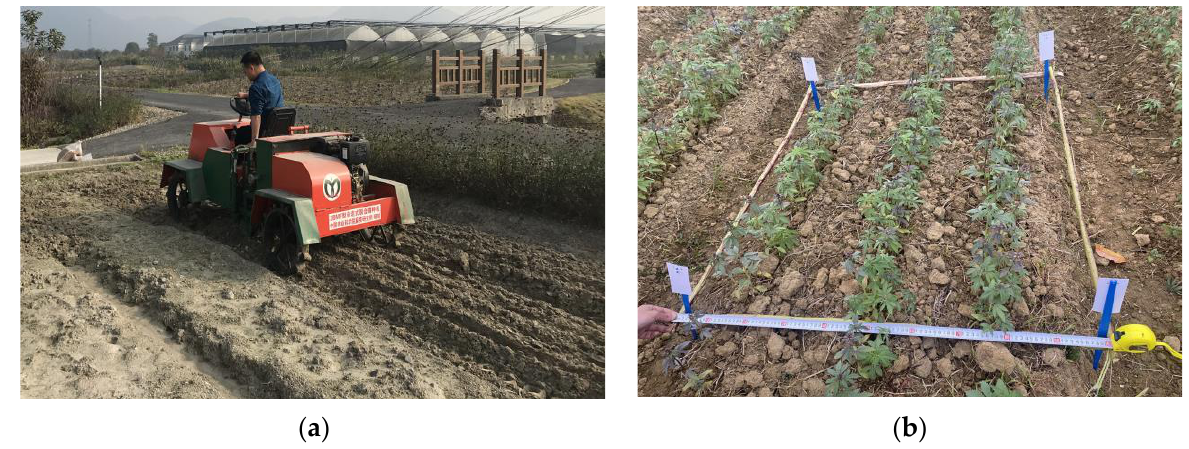
Figure 15. The field test. ( a ) Seeder field operation. ( b ) Growth of industrial hemp. The experiment took “Long Ma 3” as the seed row object, sowing 3 rows in each stroke with a row spacing of 150 mm. After seedling emergence, according to the distribution of industrial hemp in the field, 5 sections of each row were randomly tested. The verification results are shown in Table 6. The average variation coefficient of actual seeding uniformity is 6.19%, the average coefficient of variation for consistency of seed quantity in each row is 3.44%, and the coefficient is less than 8.0%, which meets the design requirements. The test results are consistent with the optimization results, which are credible. Table 6. Verified results.